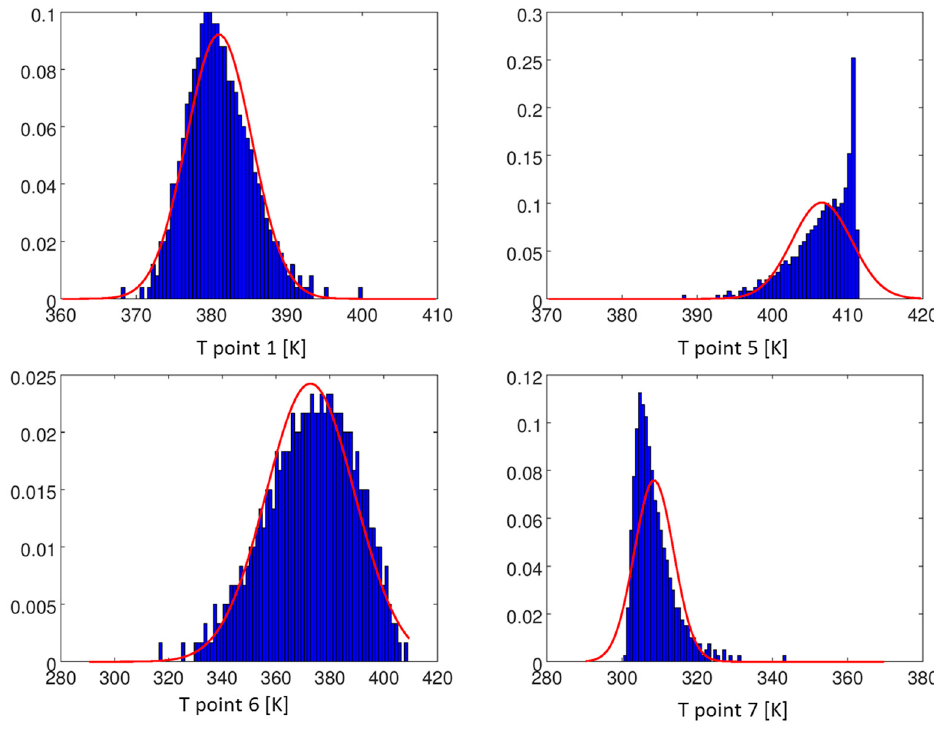
Figure 23. Pdf of maximum temperature with normal input distribution of α .